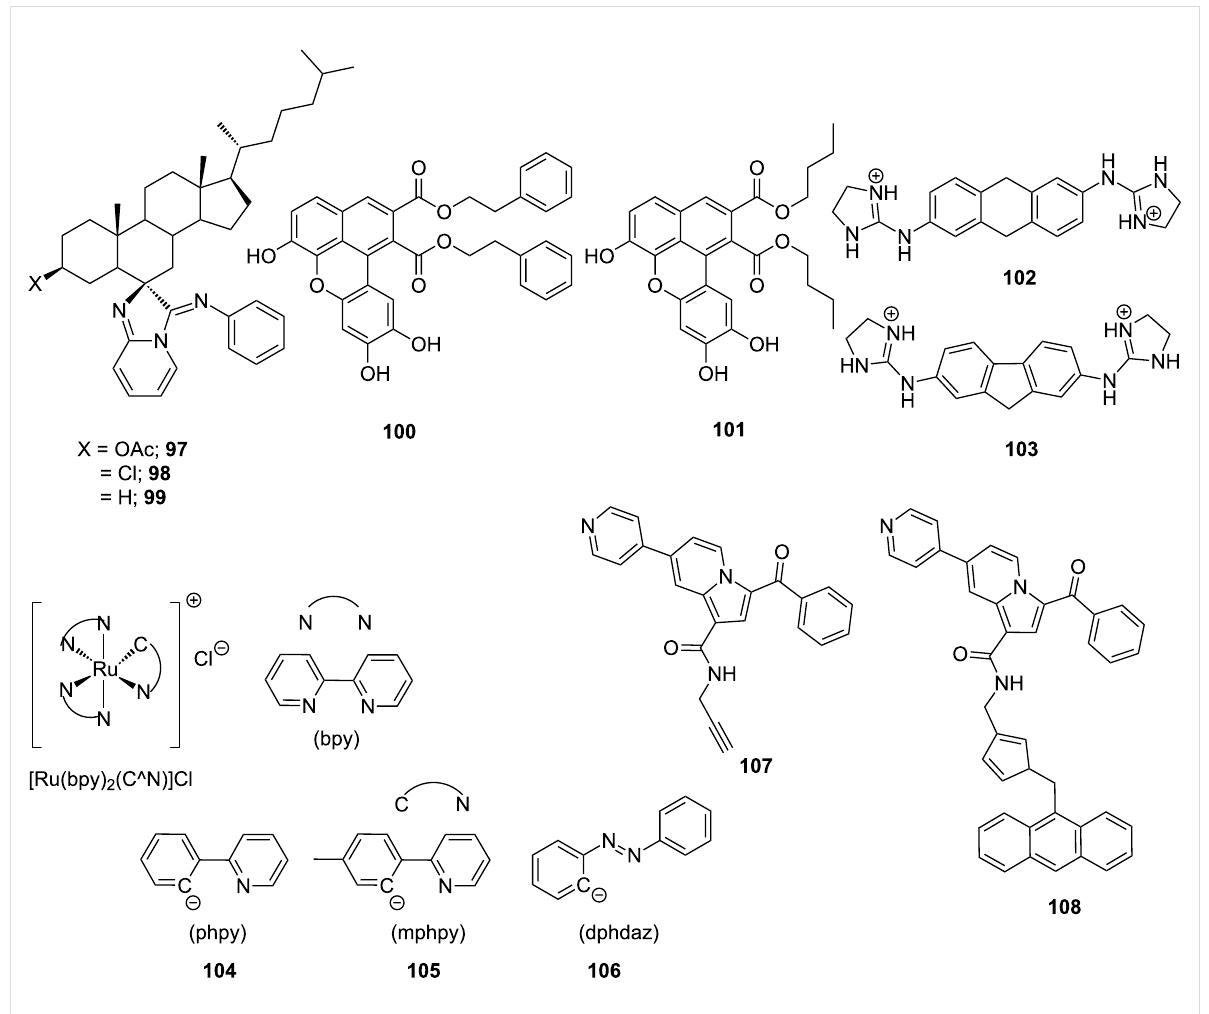
Figure 17: Several recent synthetic varieties of DNA